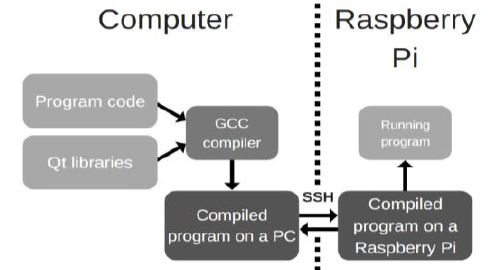
Fig. 1. Block diagram of an intelligent multimeter .